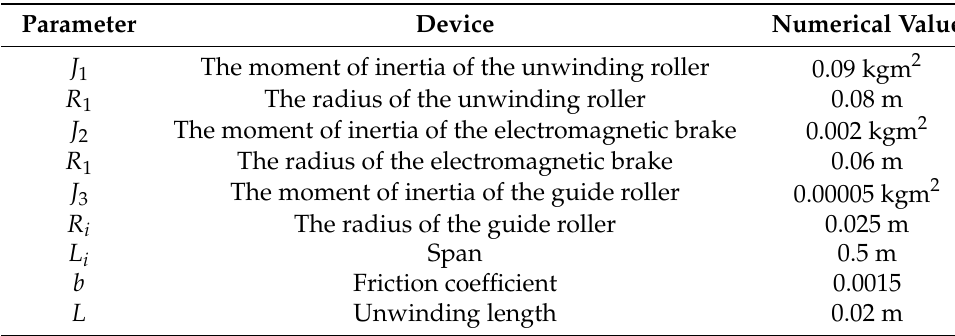
Table 4. System mechanical parameters.